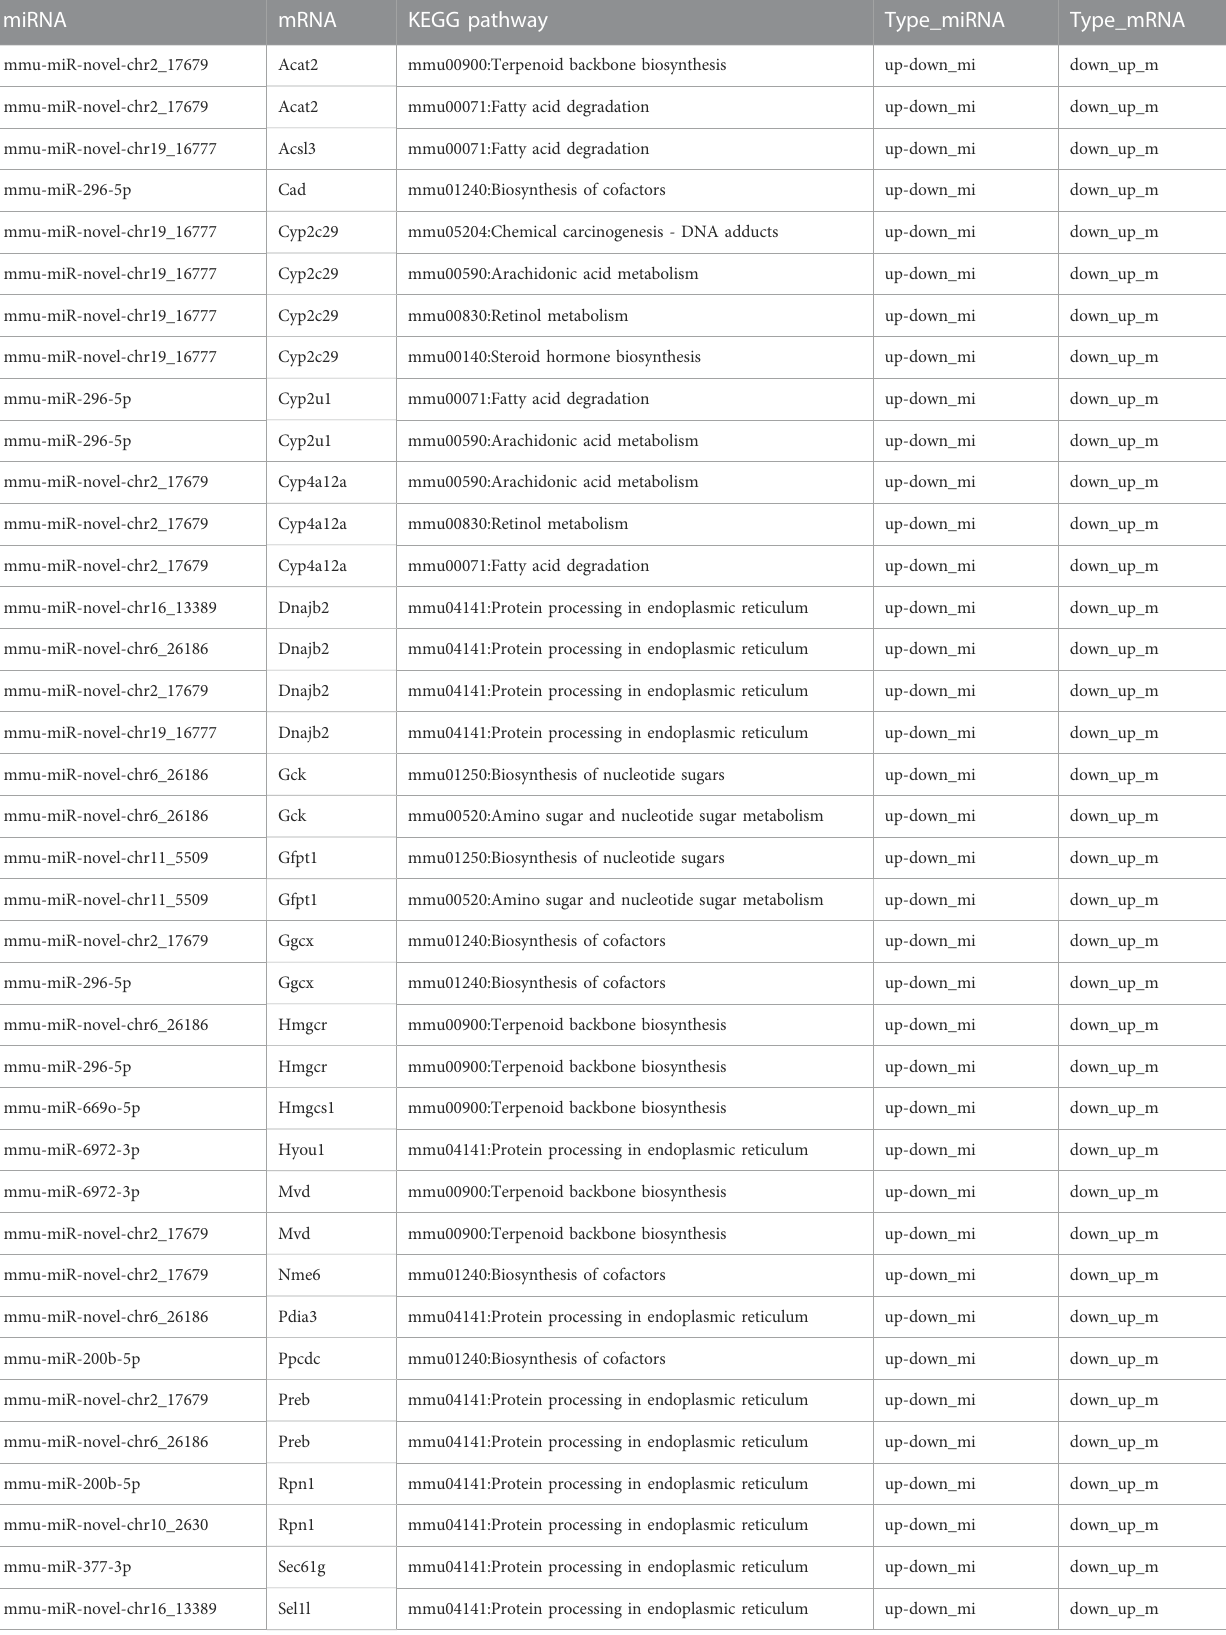
TABLE 4 Identi fi ed miRNA – mRNA-pathway pairs.